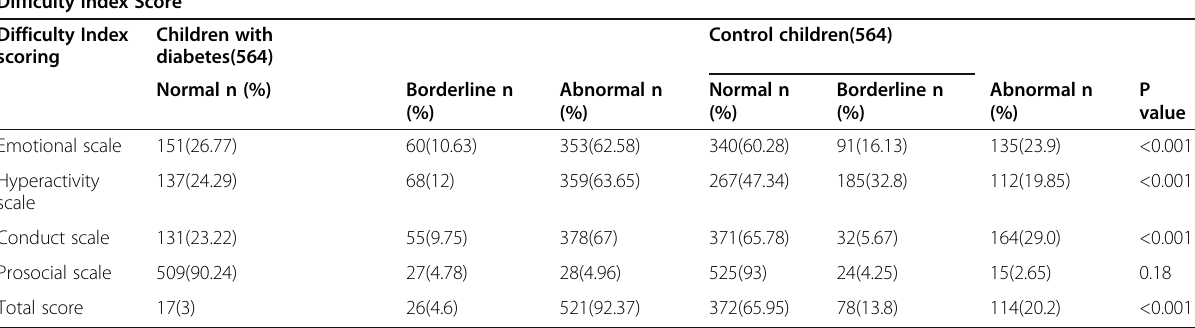
Table 1 Difficulty Index Scores of diabetic and control children Difficulty Index